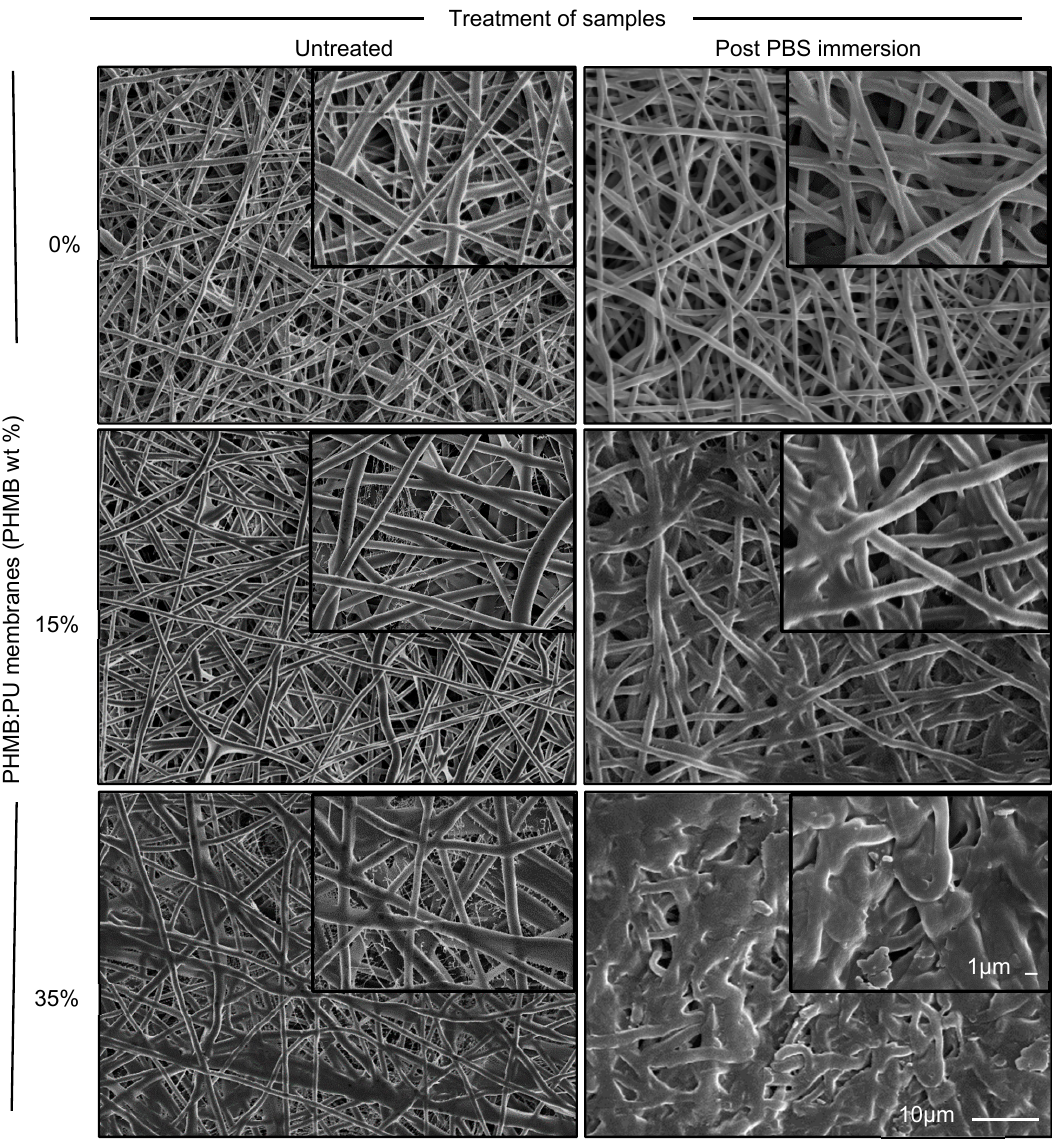
Figure 1. Representative scanning electron microscopy images of 0-, 15- and 35PHMB:PU electrospun membranes. Images are representative of untreated membranes and membranes after immersion in PBS for 24 h. Scale bars are for both untreated and treated